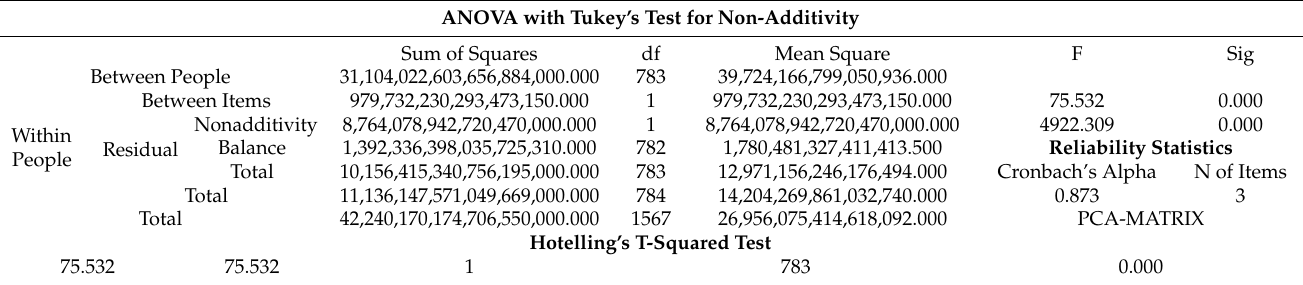
Table 8. Results of the second sub-factor (F1.2) of sustainable profit through reliability analysis.